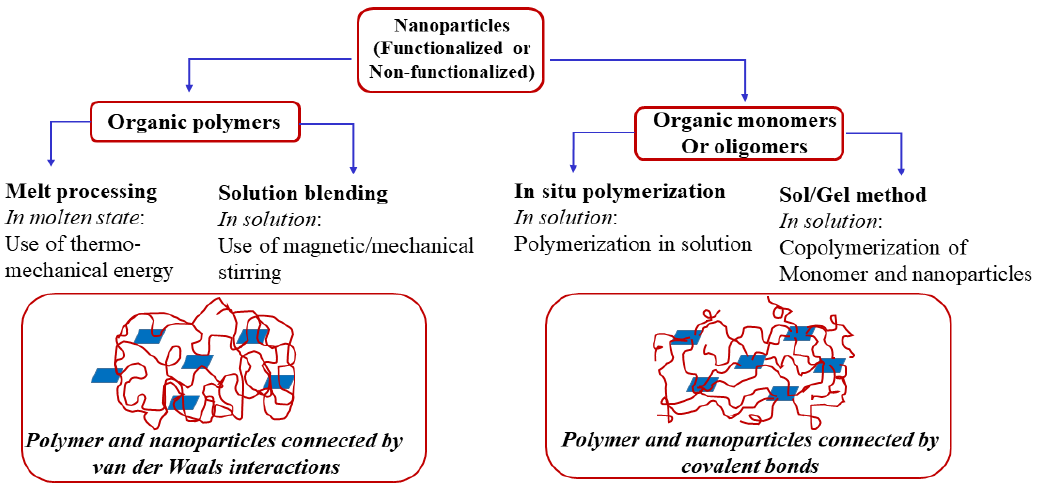
Figure 2. Outline of polymer nanocomposite preparation techniques.